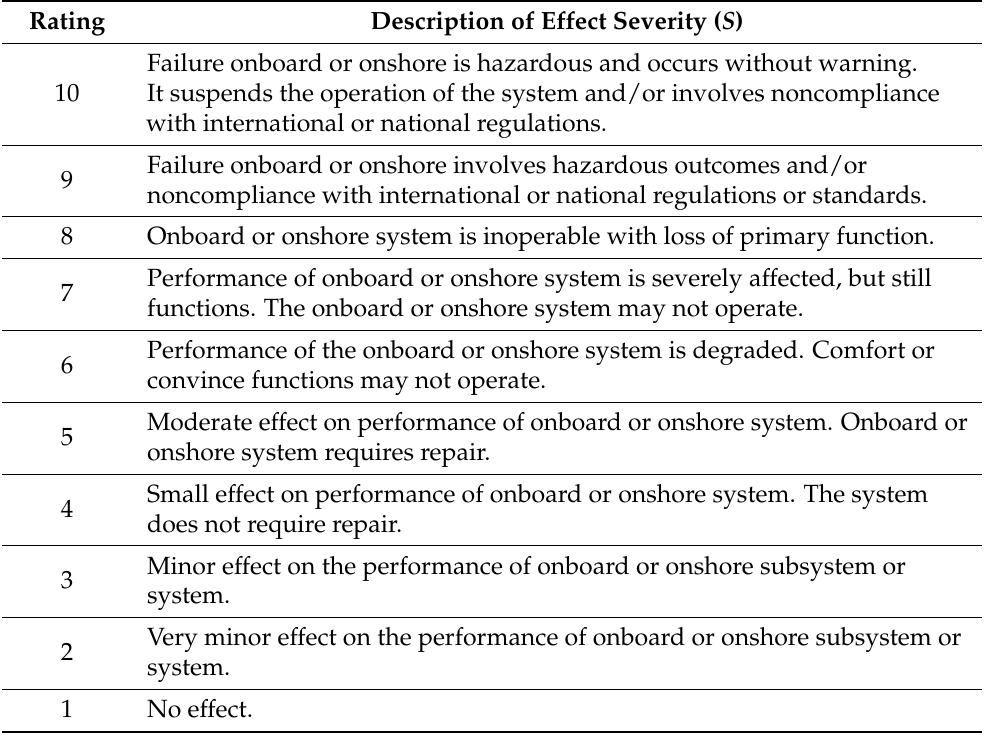
Table 3. Ratings for severity of a failure mode for a MASS system.